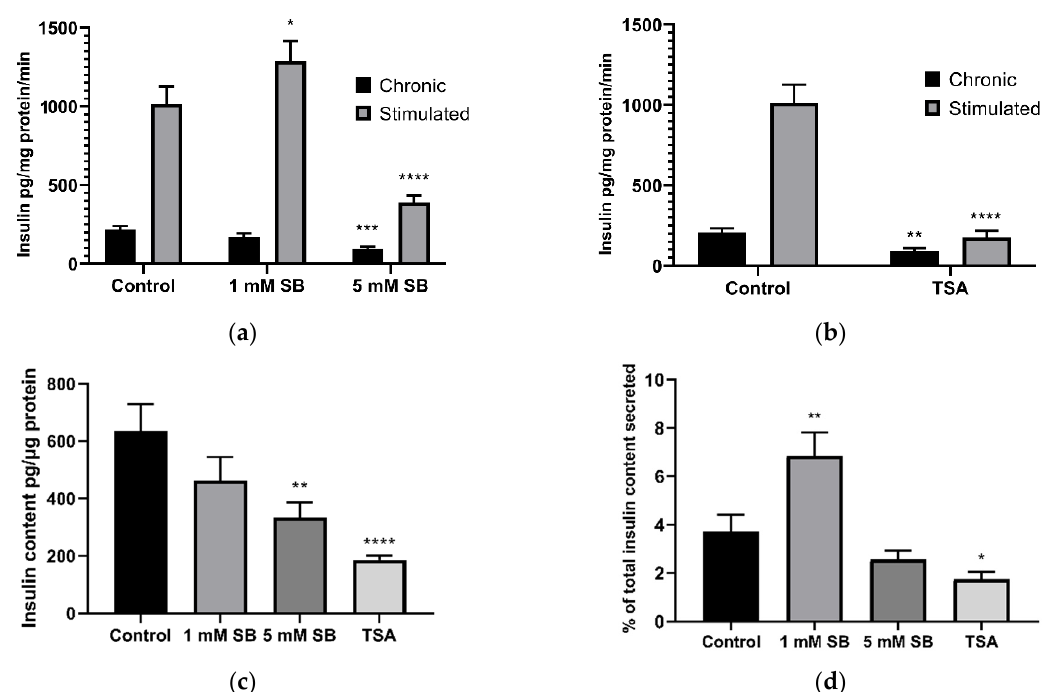
Figure 2. Insulin secretion following 24 h treatment with butyrate and 2.5 µM TSA in BRIN-BD11 cells. The effect of 24 h exposure to ( a ) sodium butyrate (SB) and ( b ) 2.5 µM trichostatin A (TSA) on 24 h (chronic) insulin secretion and in response to acute stimulation by 16.7 mM glucose and 10 mM alanine for 20 min (stimulated); ( c ) the effect of 24 h treatment of sodium butyrate and TSA on BRIN-BD11 cellular insulin content; ( d ) the percentage of total insulin secreted in response to stimulation per the insulin content of unstimulated cells. Results are means combined from at least 3 independent experiments + SEM. * p < 0.05, ** p < 0.01, *** p < 0.001, **** p < 0.0001 compared to the relative untreated control.